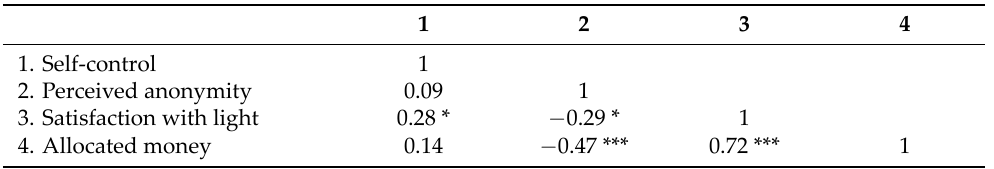
Table 4. Correlations among self‑control, perceived anonymity, satisfaction with light and the amount of allocated money in dictator